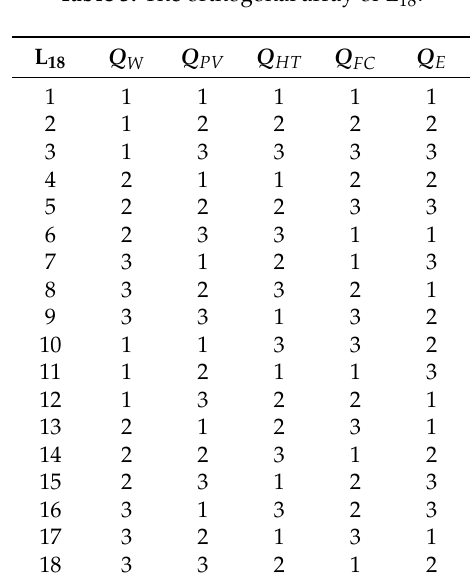
Table 3. The orthogonal array of L 18